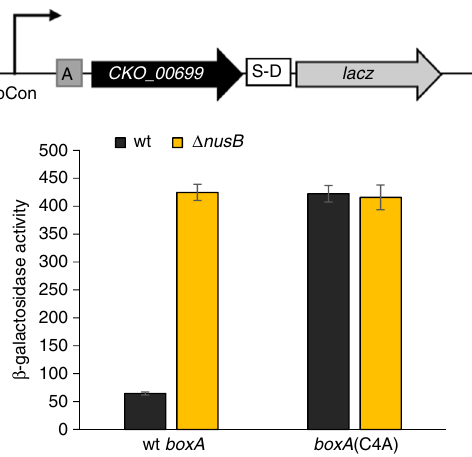
Fig. 6 Identi fi cation of a BoxA element in Citrobacter koseri . β -galactosidase activity of wild-type ( ‘ wt boxA ’ ) and boxA mutant ( ‘ C4A ’ ) transcriptional fusions of CKO_00699 (R82A mutant, to avoid potential toxicity to E. coli in the absence of the anti-toxin) to lacZ in E. coli wild-type ( ‘ wt ’ ; dark grey bars) or nusB deletion ( ‘ Δ nusB ” ; yellow bars) strains. CKO_00699 - lacZ transcription was driven by a constitutive promoter 25 . Error bars represent ± 1 standard deviation from the mean ( n =